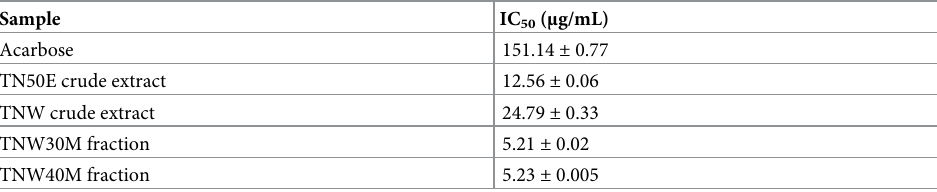
Table 2. α -Glucosidase inhibitory effect (IC 50 ) of different TN extracts compared to